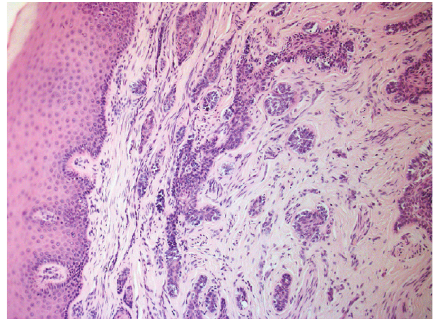
Figure 6: Plexiform pattern.